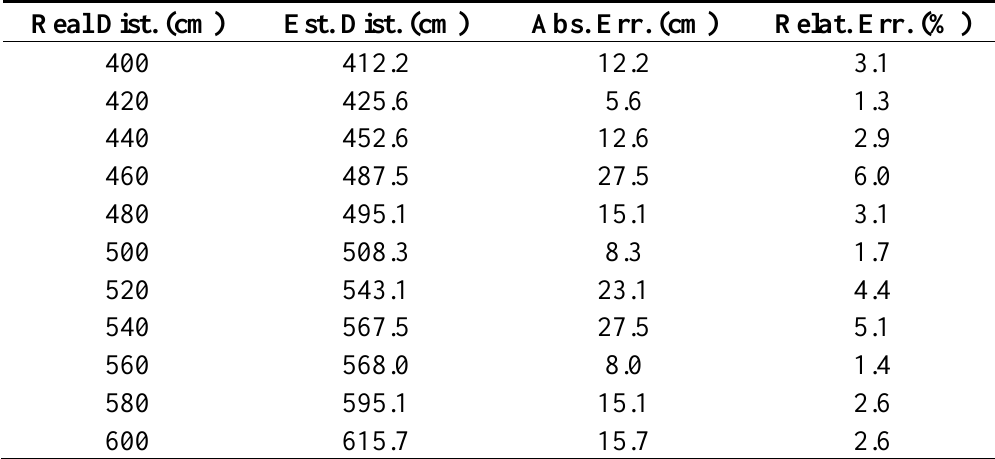
Table 2. Final distance estimation result for Experiment